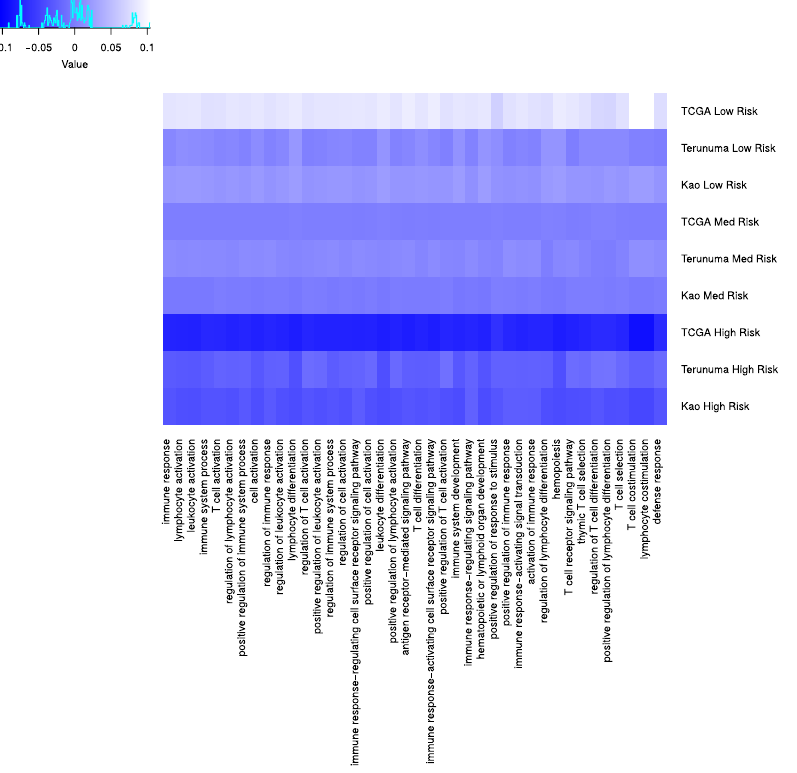
Figure 6. Mean relative expression of biological process pathways enriched for genes in the M2EFM gene signature. The pathways are composed primarily of immune-related functions. The heat map shows the mean relative expression of genes from our signature in each pathway for each overall survival dataset. The data are subset into samples predicted by M2EFM to be at low, medium, or high risk. There is a trend toward repression of the pathways as the risk score goes from low to